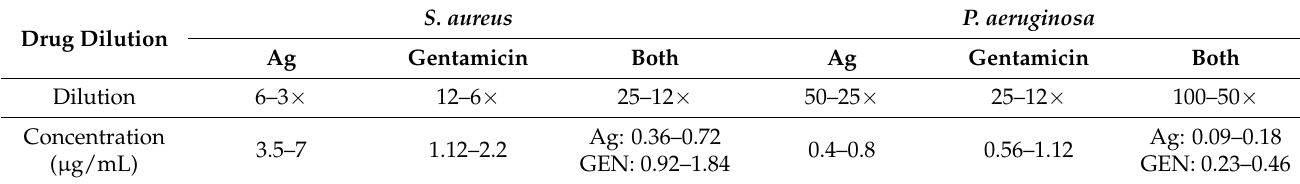
Table 3. MIC 100 values obtained from day 7 drug release media for bone cement loaded with silver nitrate, gentamicin or both. Table shows the degree of dilution necessary for the release media to kill the bacteria as well as the concentration of drug(s) in that release media.